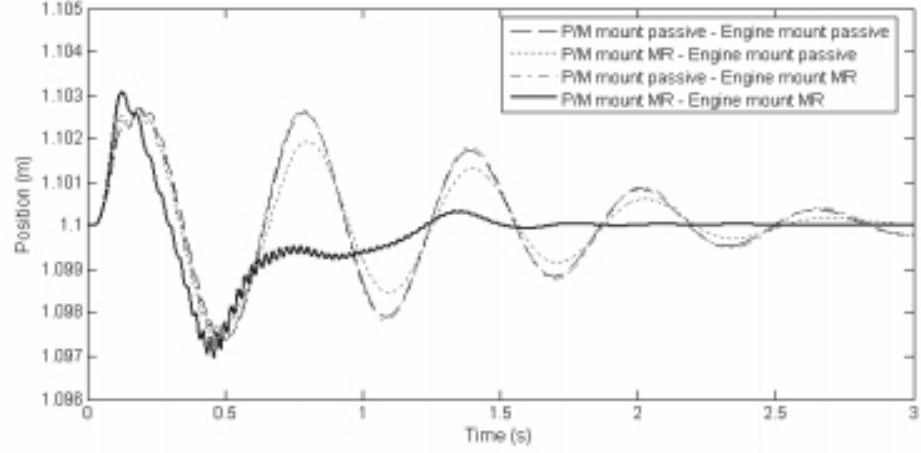
Fig. 6. Position of the engine in time